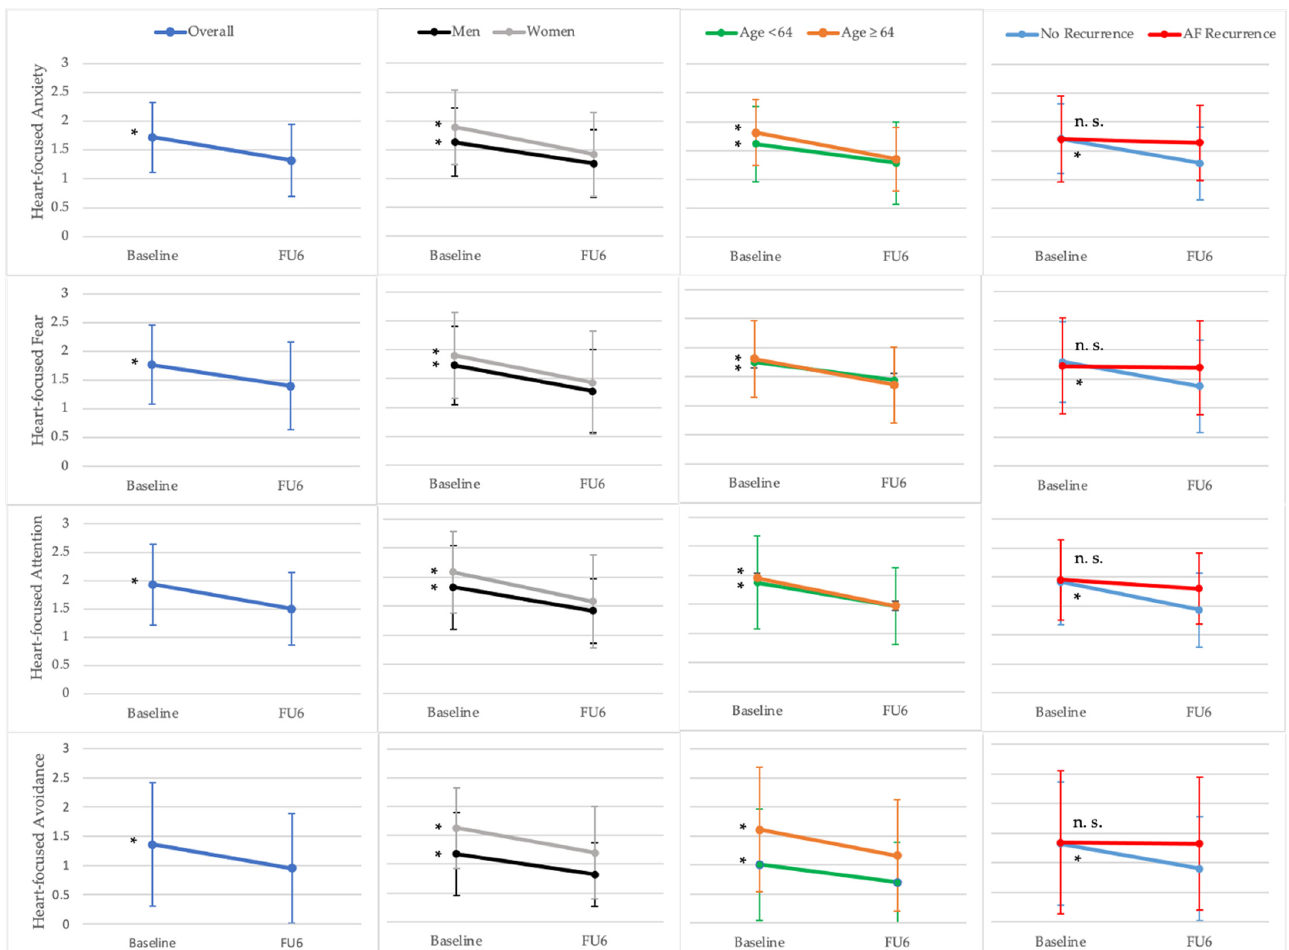
Figure 2. Heart-focused anxiety (HFA) with related sub-scores at baseline and 6 months follow-up (FU6). Results for paired t -tests and repeated measures ANOVA with the within-subject factor time (baseline, FU6) and the between-subject factor group (gender, age, documented atrial fibrillation (AF) recurrence). * p < 0.05 for paired t -test; n.s., not significant. Data points represent mean scores of the Cardiac Anxiety Questionnaire (CAQ) and sub-scores (HFA anxiety (total score), HFA fear, HFA attention and HFA avoidance). The error bars indicate the standard deviation.